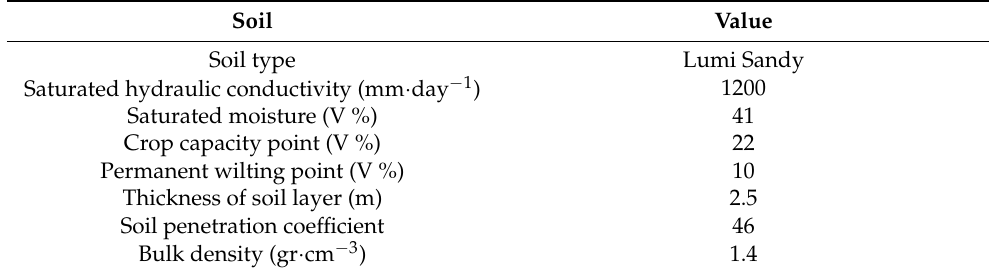
Table 4. Soil input data for the model.